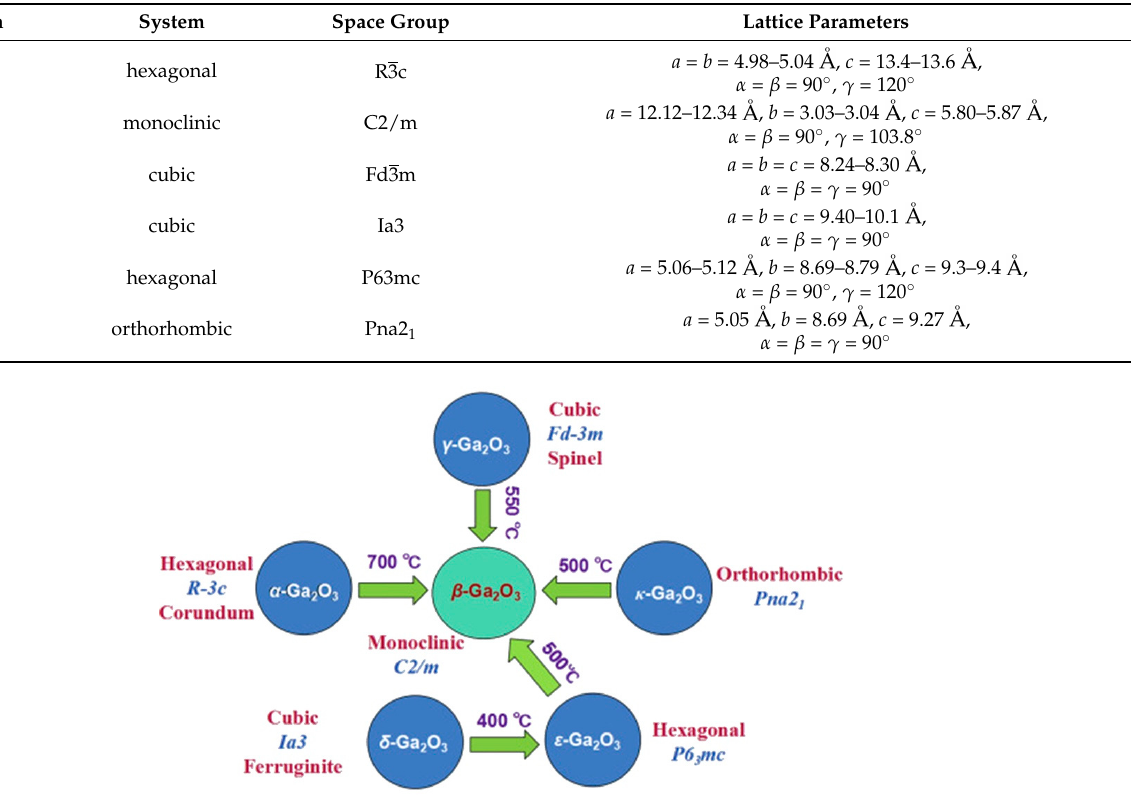
Table 1. Basic properties of Ga 2 O 3 polymorphs [22,32].